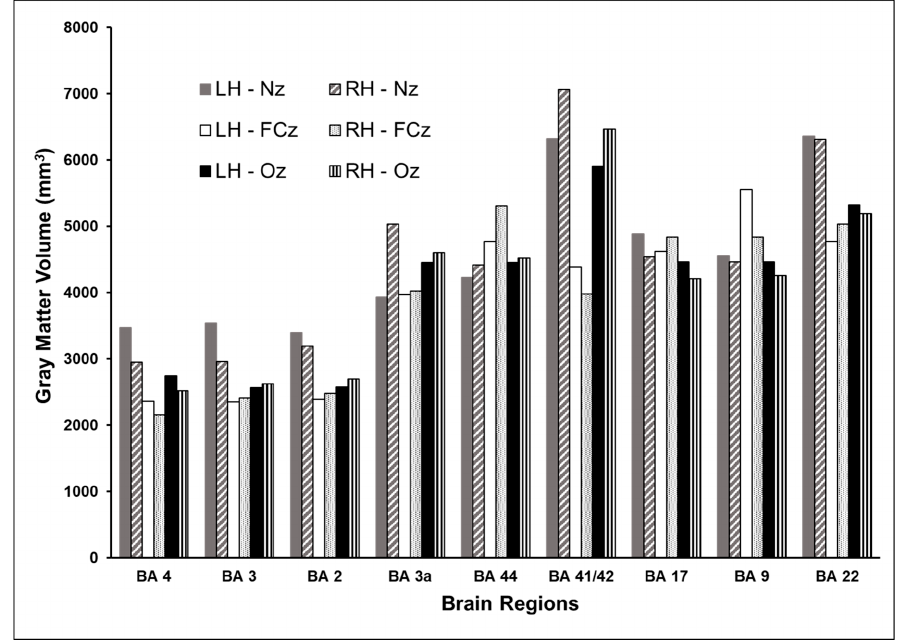
Figure 8. Effect of the TMS coil direction on the volume of activated cortex. Coil orientations examined were pointing to Nz, FCz, or Oz electrodes on 10-10 EEG system. The TMS intensity modeled was dI/dt = 150 A/µs. For most locations, coil pointing to the nose resulted in larger volume of cortex experiencing at least 75% of the maximum E-field than the other two orientations. The coil oriented to the nose also had more variability between the homologous regions in the two hemispheres.